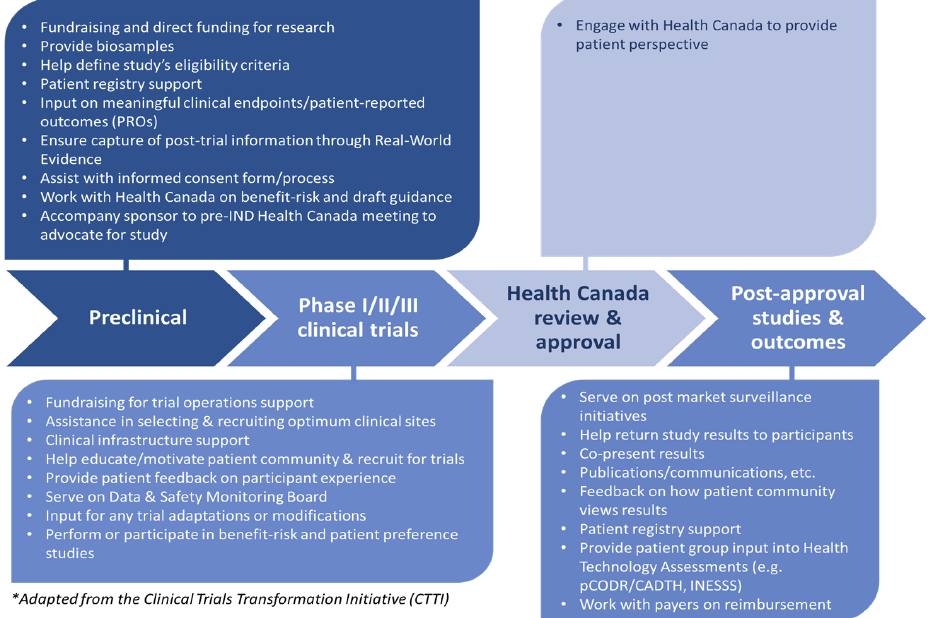
Figure 1. Canadianized Clinical Trials Transformation Initiative (C-CTTI)—a model of a PG pathway for engagement in cancer clinical trials (CTs) in Canada.